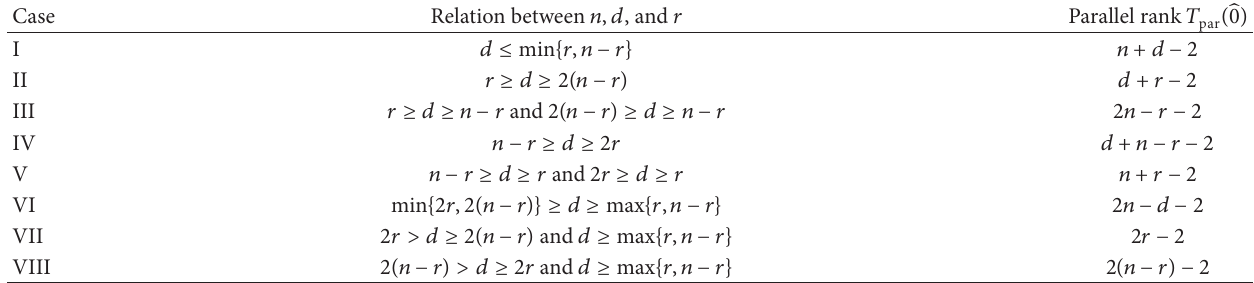
Table 1: Parallel rank in 𝑃(𝑛 , 𝑑 , 𝑟) .